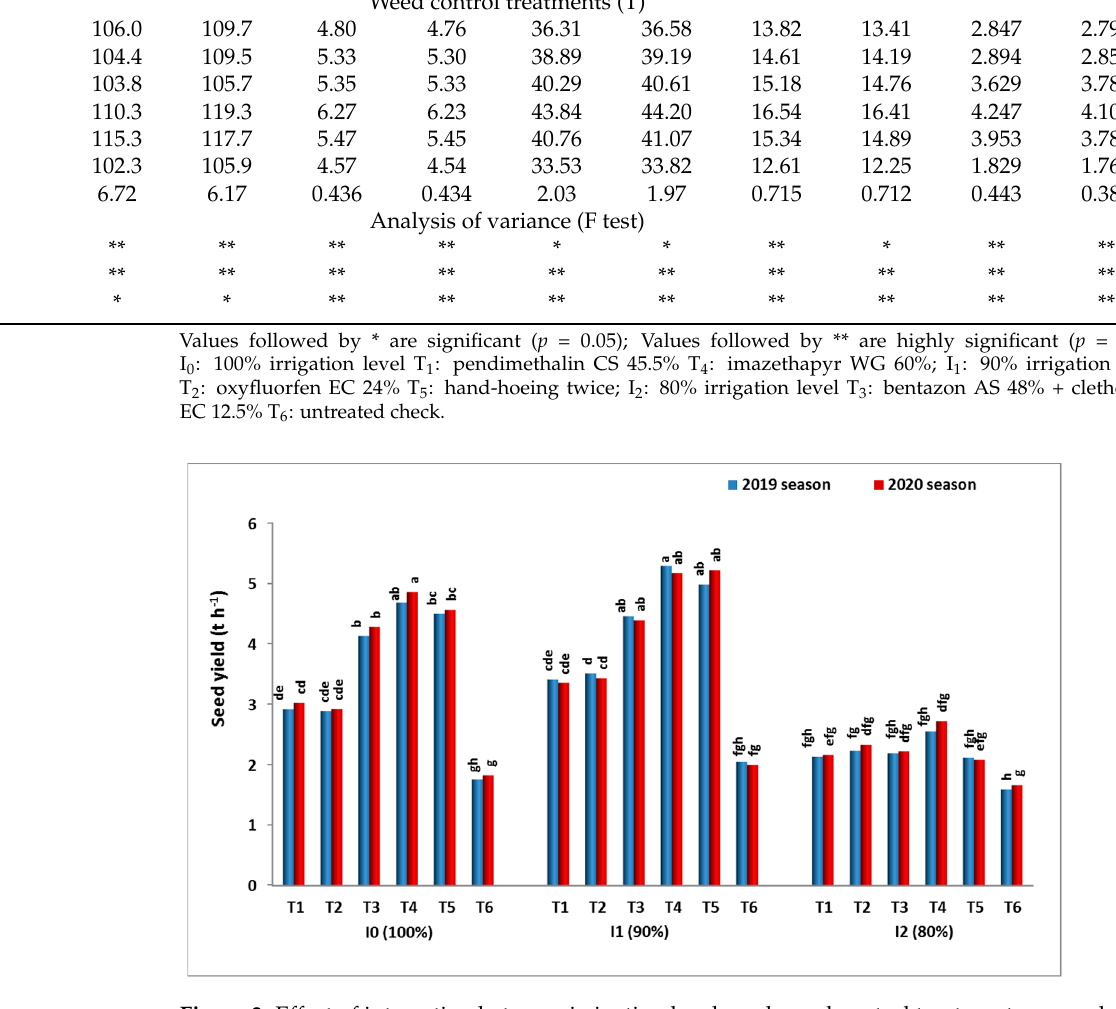
Figure 3. Effect of interaction between irrigation levels and weed control treatments on seed yield of soybean in the 2019 and 2020 seasons. I 0 : 100% irrigation level, T 1 : pendimethalin CS 45.5%, T 4 : imazethapyr WG 60%; I 1 : 90% irrigation level, T 2 : oxyfluorfen EC 24%, T 5 : hand-hoeing twice; I 2 : 80% irrigation level, T 3 : bentazon AS 48% + clethodim EC 12.5%, T 6 : untreated check. Different letters represent significant differences (0.05).